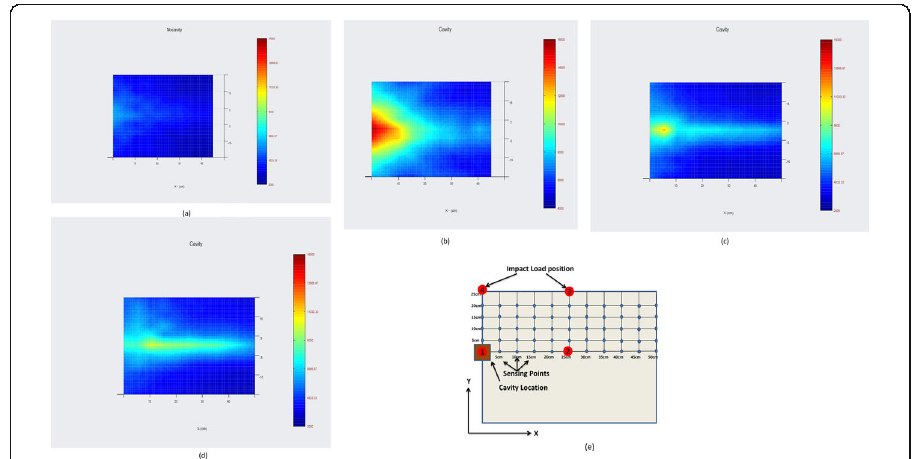
Fig. 26 Verification of the cavity using PSD values: a Ip on center where there is no cavity. b Ip on center where there is a cavity. c Impact load at 5cm from the cavity location. d Impact load at 10cm from the cavity location. e Concrete slab track sensing